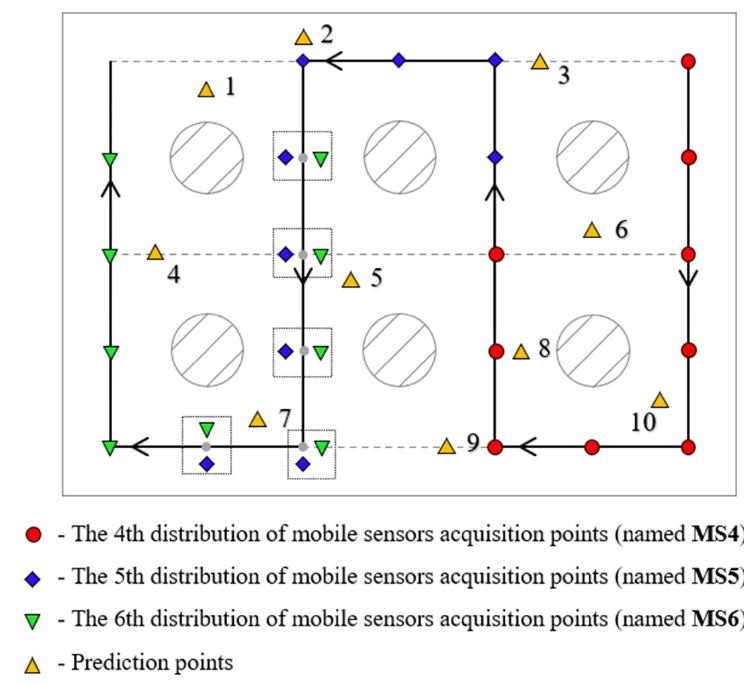
Figure 11. Prediction of mobile sensors with acquisition distance of 1.0 m.